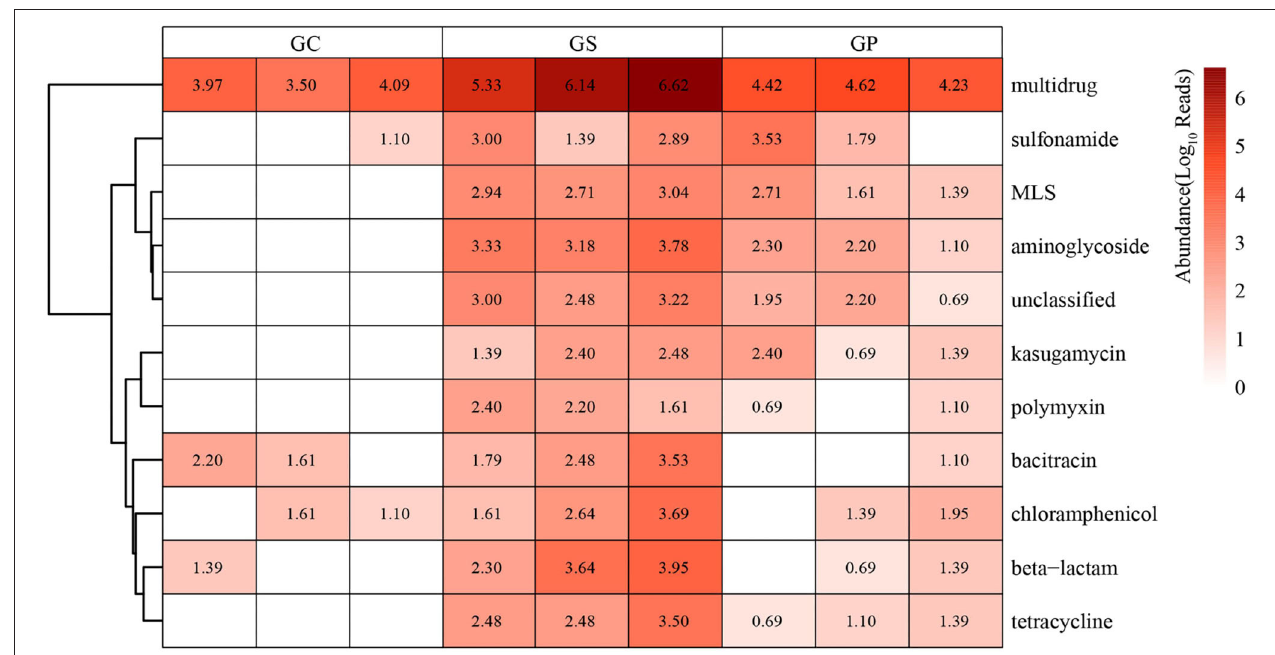
FIGURE 3 | The distribution of ARGs. Heatmap showed the distribution of ARGs in different types of products during GP processing.